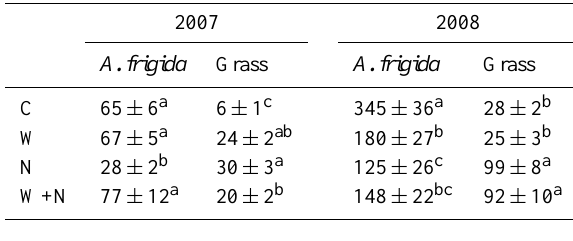
Table 2. Average biomass (mean ± 1SE, gm − 2 ) of A. frigida and grass in the control (C), warming (W), N addition (N), and warm- ing+N addition (W+N) plots across the growing season in 2007 and 2008. Different letters in the same column indicated significant dif- ference ( p < 0 . 05) among the treatments.